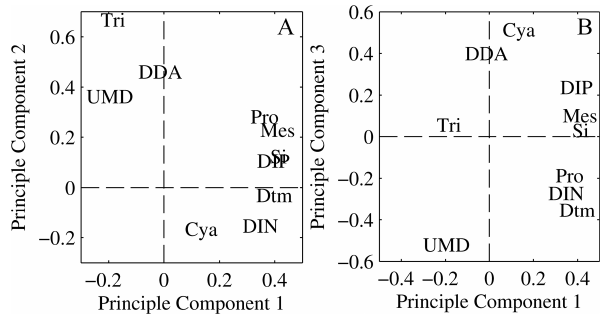
Figure 10. Principle component (PC) analysis of model nutrients and living state variables. Left panel shows PC 1 (39.5% of the variance) on the x axis and PC 2 (15.8% of the variance) on the y- axis. Right panel again has PC 1 on the x-axis, but has PC 3 (12.7% of the variance) on the y